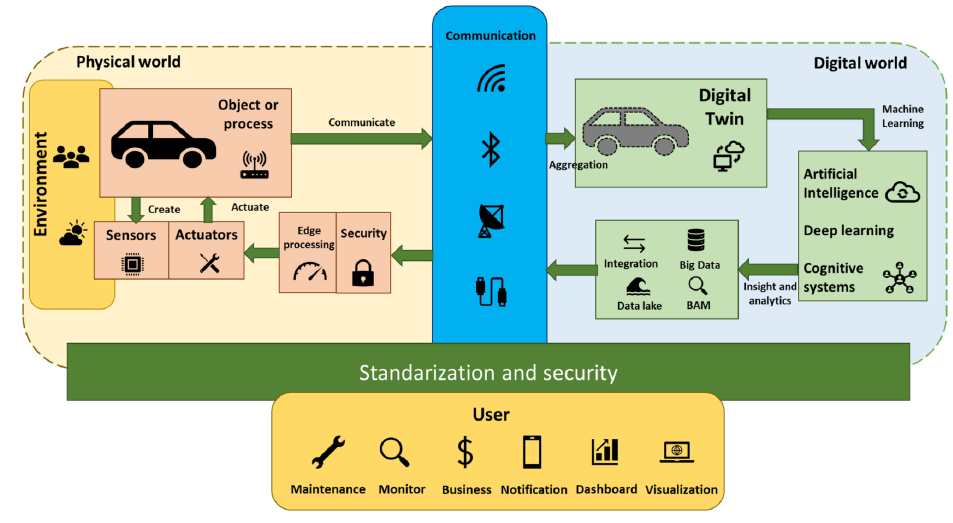
Figure 3. DT architecture